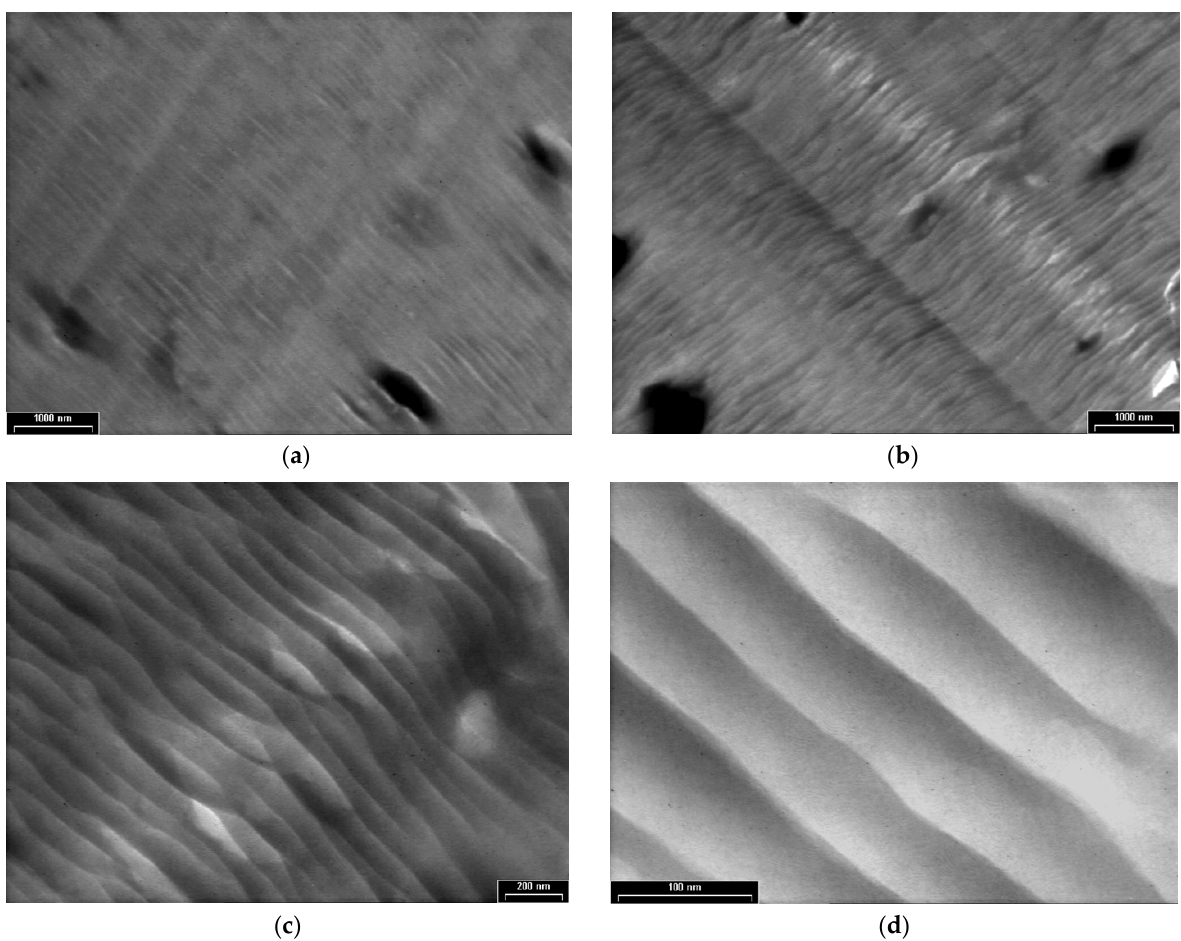
Figure 6. TEM images of PPAni-PDPA thin films at various magnifications, with scale bars ( a ) and ( b ) 1000 nm ( c ) 200 nm ( d ) 100 nm.